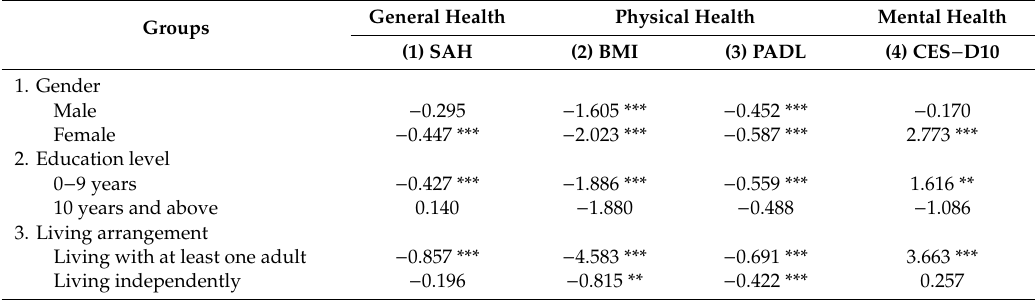
Table 3. Heterogeneity e ff ects of child migration on parental